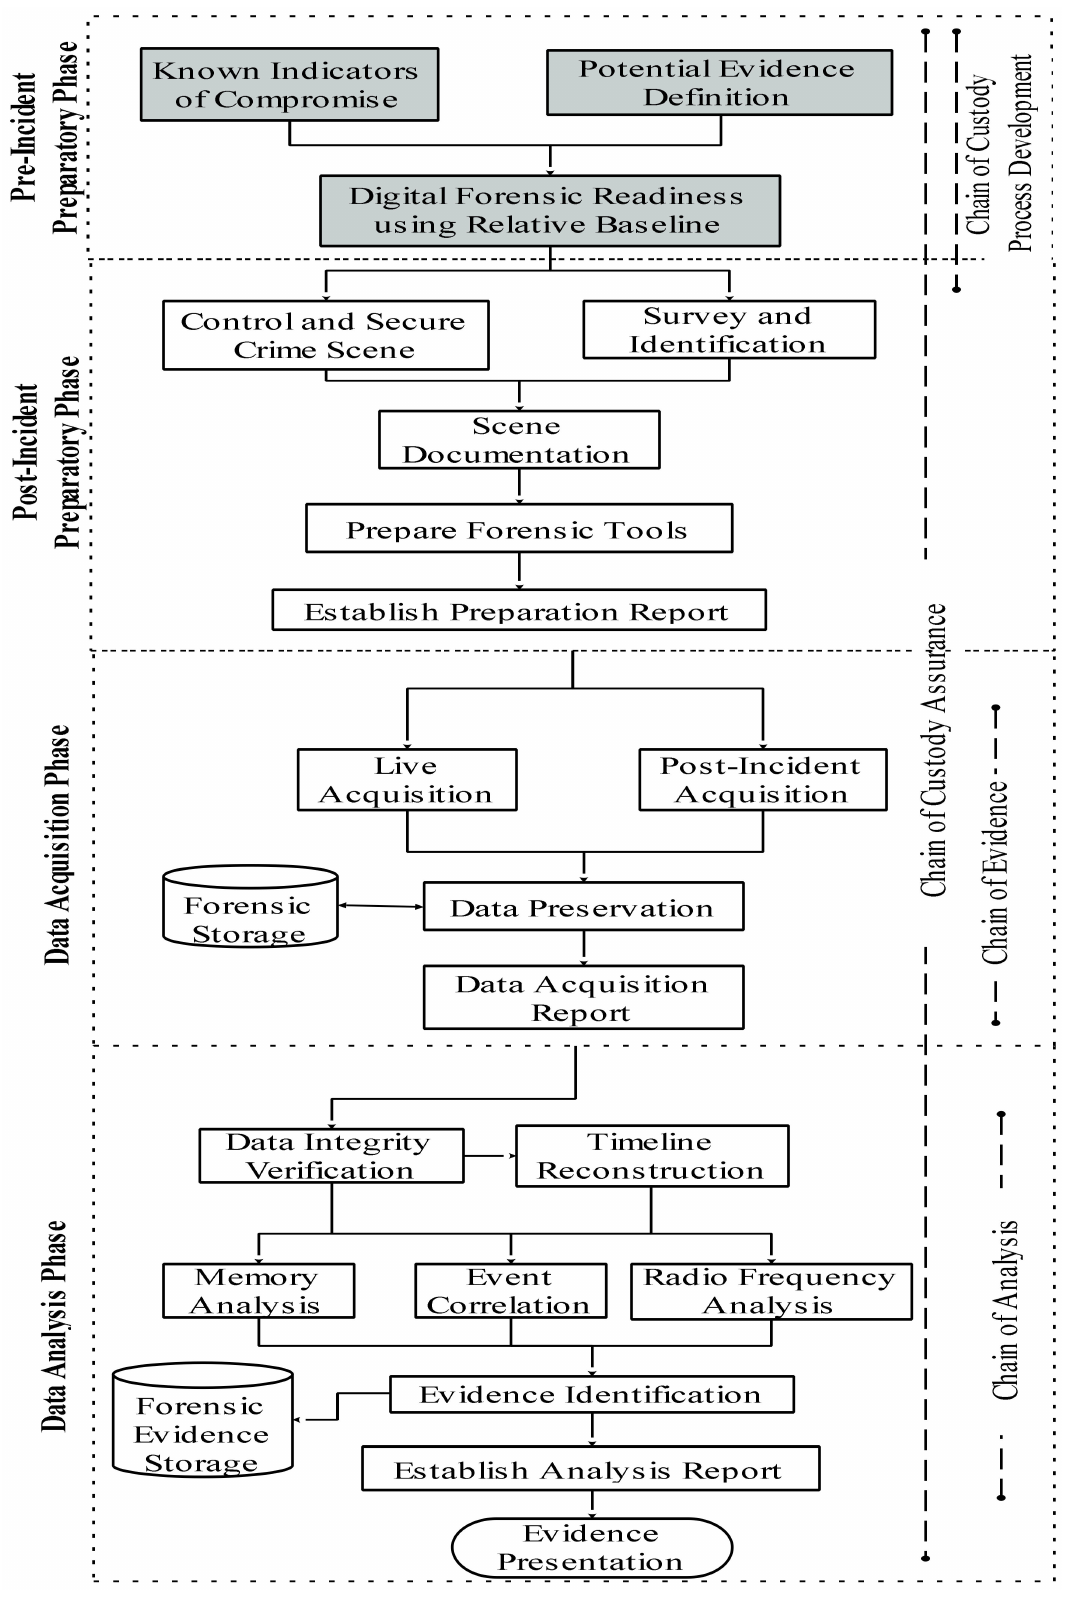
Figure 4. Integrated UAV forensic investigation